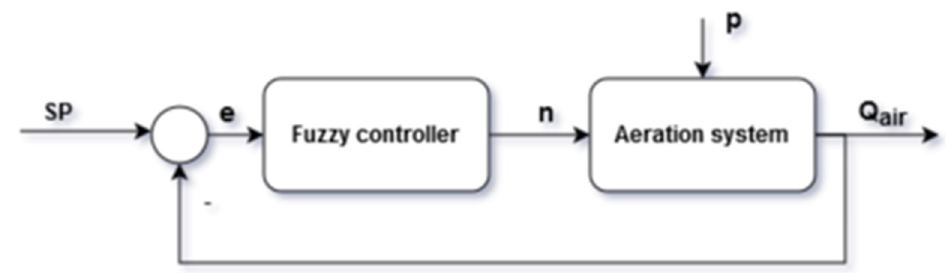
Figure 9. Structure of the control system.